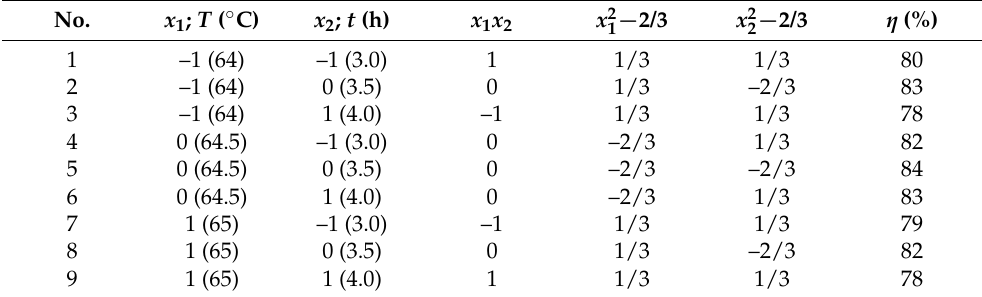
Table 2. Dimensionless variables and the measured reaction’s yield for obtaining the compound VI .